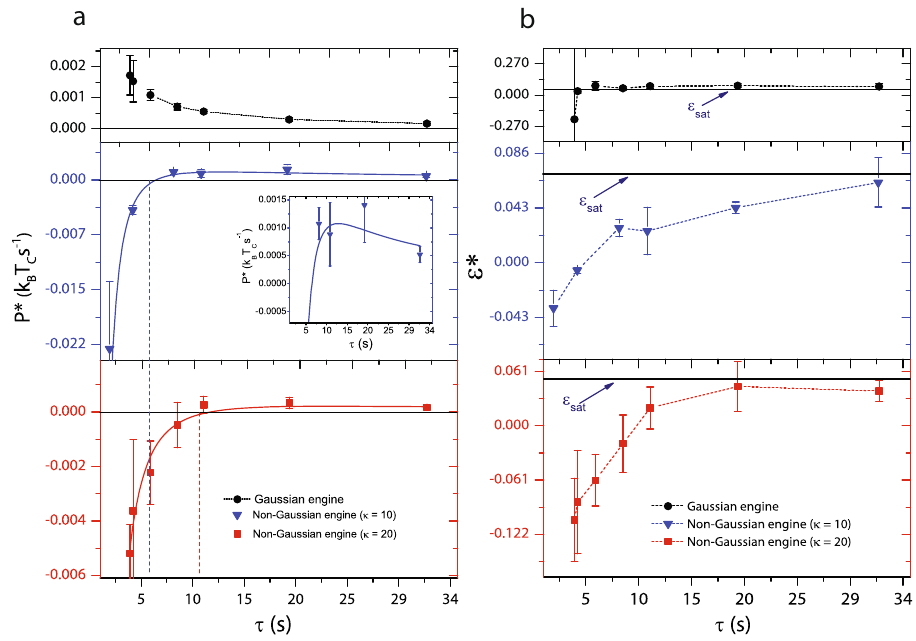
Fig. 3 Quantifying the performance of the non-Gaussian Stirling engine. a The most probable power P * with τ . Black circles represent P * for the Gaussian engine, blue triangles represent P * for the non-Gaussian engine with κ = 10 at the hot reservoir and red squares represent P * for the non-Gaussian engine with κ = 20 at the hot reservoir. With decreasing τ , P * increases considerably (inset) for the non-Gaussian engine with κ = 10 at the hot reservoir and rapidly falls off for τ ≤ 8 s. For the non-Gaussian engine with κ = 20 at the hot reservoir, the increase in P * is rather small and it decays for τ ≤ 10.6 s. The blue and red solid lines are calculated from the fi t to Eq. (1) and are overlaid on the experimental data. The blue (red) vertical dashed line indicates the τ below which P * is negative for the non-Gaussian engine with κ = 10 ( κ = 20) at the hot reservoir. b The most-probable ef fi ciency ε * for various τ . Black circles represent ε * for the Gaussian engine, blue triangles represent ε * for the non-Gaussian engine with κ = 10 at the hot reservoir and red squares represent ε * for the non-Gaussian engine with κ = 20 at the hot reservoir. The blue solid lines indicate the theoretically calculated Stirling saturation, ε Sat . Ef fi ciency ε just before the rapid drop in power at τ = 8 s ( τ = 10.6 s) of the non-Gaussian engine with κ = 10 ( κ = 20) at the hot reservoir agrees with Max the Curzon – Ahlborn ef fi ciency ε CA . The error bars indicate the standard deviations of the mean and the most probable quantities across different experiments. Note that the black vertical line through the fi rst data point (smallest τ ) is a portion of a large error bar. The error bars at other τ values are smaller than the symbol